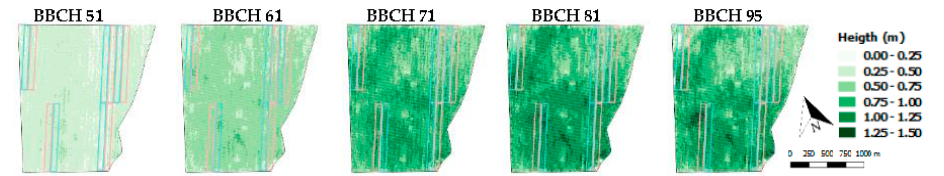
Figure 7. Spatial distribution of crop height in five phenological stages of narrow-row cotton in field NF2.